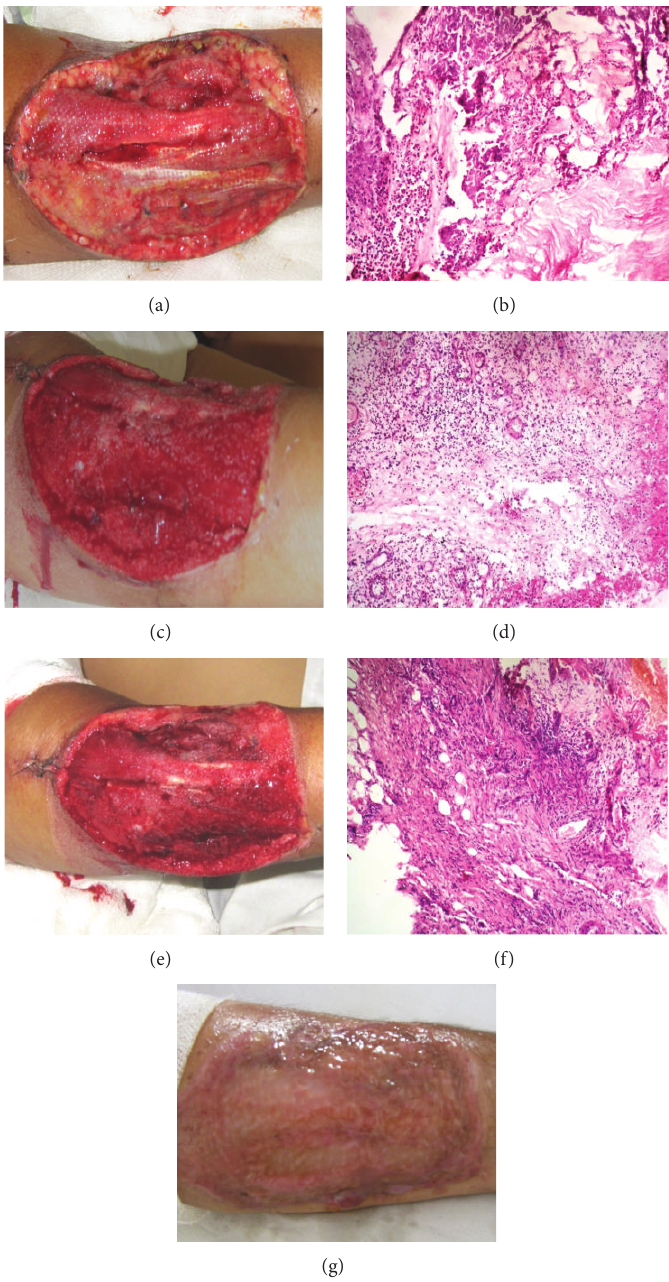
Figure 5: (a) Day 0: wound size, 146 × 135 mm. (b) Day 0: photomicrograph number 1-H and E stained section (100x) shows: dense neutrophilic exudates on the surface of wound. (c) Day 4: wound size, 130 × 120mm. (d) Day 4: photomicrograph number 2-H and E stained section (100x) shows: fibrinous exhudate on the surface and base of ulcer is formed by moderately inflamed granulation tissue. (e) Day 8: wound size, 130 × 117mm. (f) Day 8: photomicrograph number 3-H and E stained section (100x) shows: many newly formed blood vessels and dense fibro collagenous tissue. (g) SSG uptake